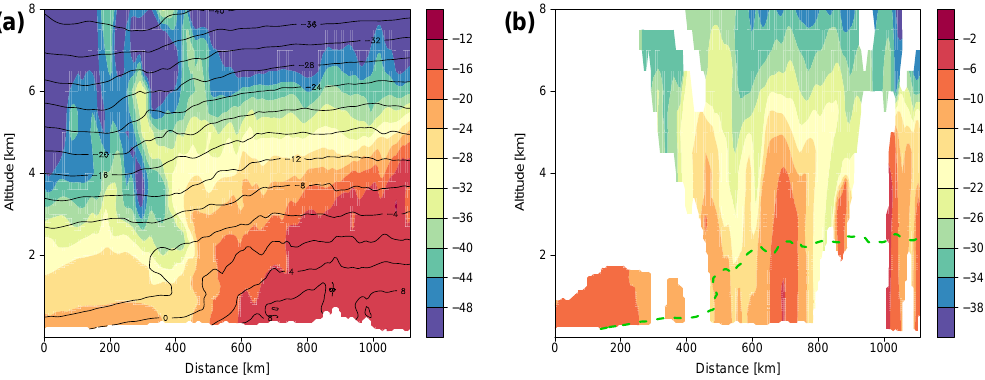
Fig. 11. Vertical cross sections from the COSMO iso sensitivity experiment in which isotopic fractionation during the interaction of rain drops and the surrounding water vapour is switched off, showing δ 18 O (in ‰) in (a) water vapour and (b) rain and snow at 12:00UTC 19 January along the green dashed line given in Fig. 3d. The contours in (a) show the temperature (in ◦ C), the green dashed line in (b) indicates the 0 ◦ C